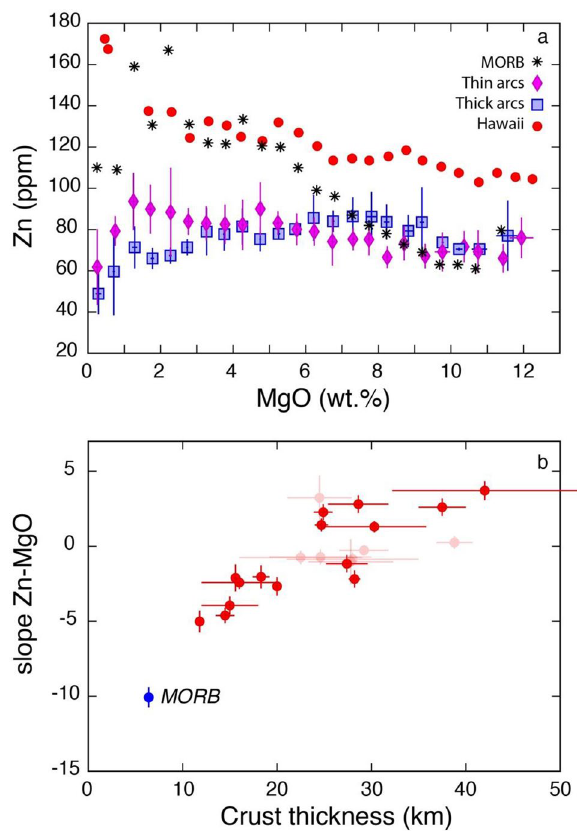
Figure 1. Zn–MgO systematics of arc, MOR and Hawaii magmatic rocks. ( a ) Zn–MgO plot of the averages of median values of all thin (< 20 km) and all thick (> 30 km) arcs compared to median values of MOR and Hawaii magmas for MgO bins ~ 0.5 wt% (data reported in Supplementary Data File 1); ( b ) plot of the Zn–MgO slopes of individual arcs and MOR magmatic rocks versus crustal thickness (data reported in Table 1). The light red symbols denote poor statistical significance for the Zn–MgO regressions (see Table